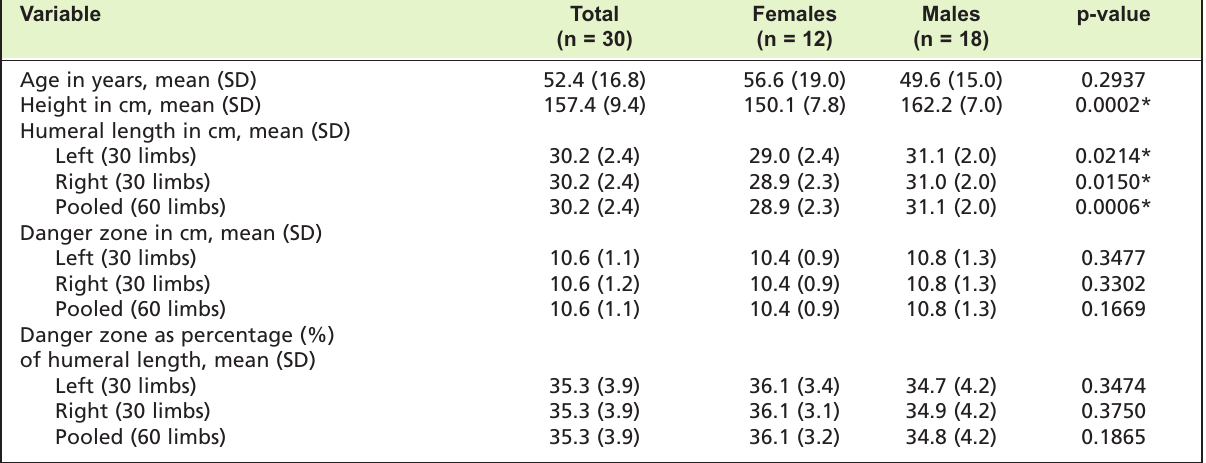
Measured characteristics of the cadavers included in the study Table I: